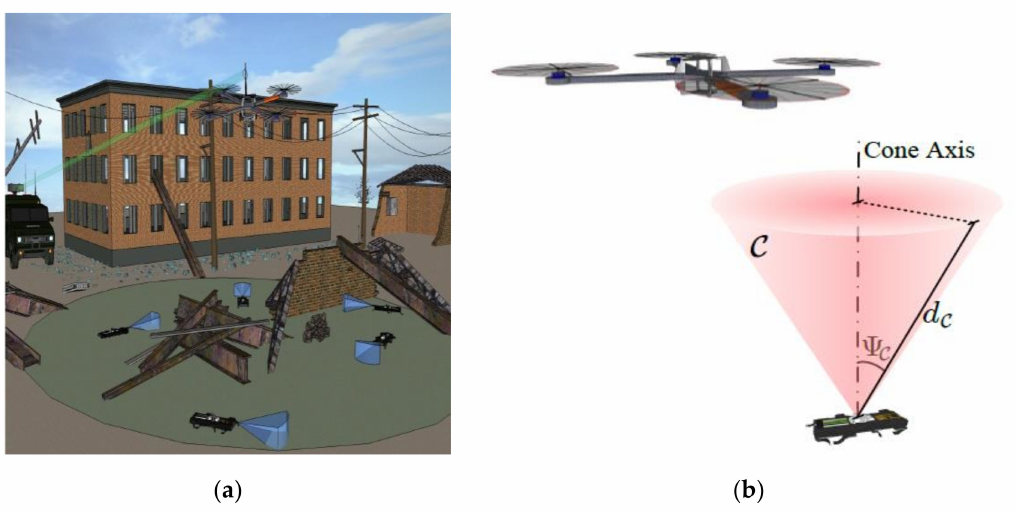
Figure 11. ( a ) A team of micro unmanned aerial and ground vehicles deployed to explore a disaster area; ( b ) connectivity cone C with its parameters